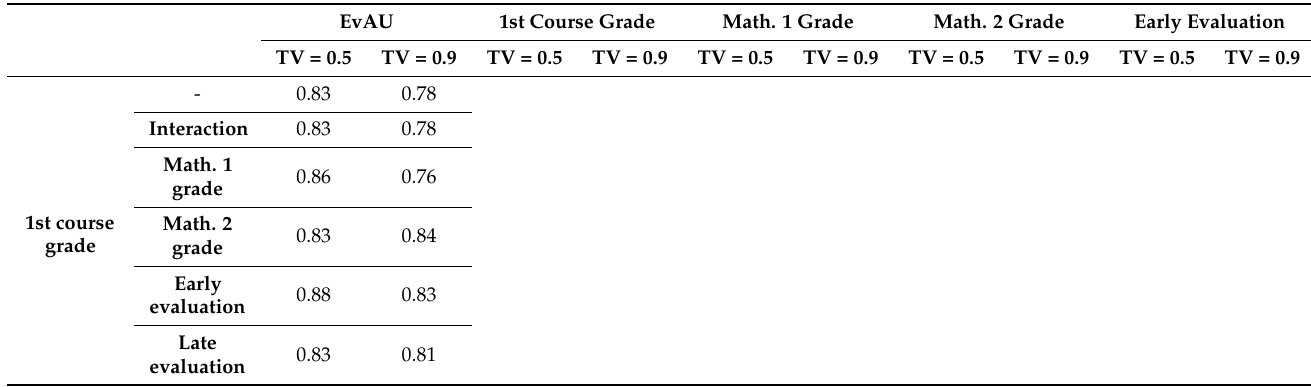
Table 3. Average precision (10-fold cross-validation) of the different models for threshold values (TVs) of 0.5 and 0.9. Variables combined three by